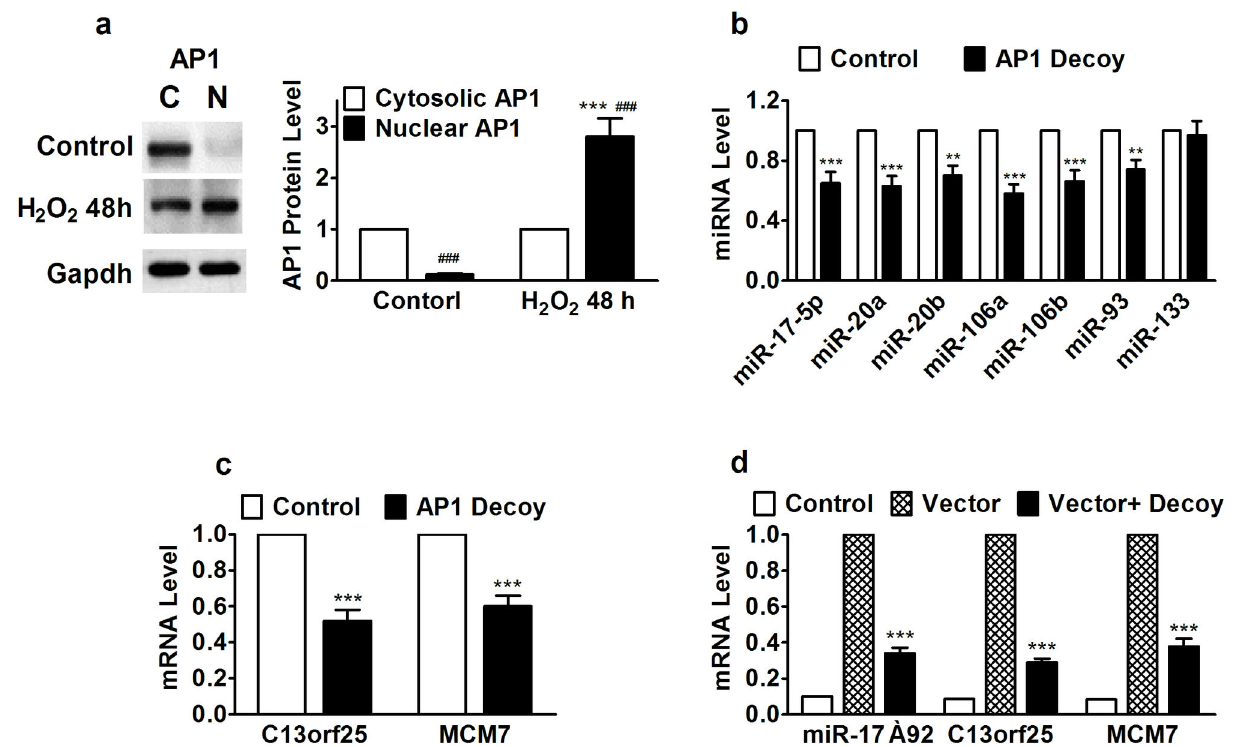
Figure 7. Effects of activating protein-1 (AP1) on transcriptional stimulation of the miR-17-5p seed miRNAs belonging to miR-17~92, miR-106a~363, and miR-106b~25 clusters in HEK293 cells. (a) Nuclear translocation of AP1 after chronic H treatment, assessed by Western blot analysis of cytosolic and nuclear AP1 protein levels. *** P <0.001 H Nuclear vs Cytosolic; n=5; (b) Effects of AP1 decoy to sequestrate AP1 on expression of miR-17-5p seed miRNAs. ** P <0.01 & *** P <0.001 H O vs Control; n=5; (c) Effects of AP1 decoy to sequestrate AP1 on expression of C13orf25 and MCM7, the host 2 2 genes of miR-106a~363 cluster and miR-106b~25 cluster, respectively. ** P <0.01 & *** P <0.001 H AP1 decoy to on luciferase activities driven by luciferase vector containing the promoter regions of miR-17~92, C13orf25, and MCM7. *** P <0.001 AP1 Decoy vs Vector alone; n=6.